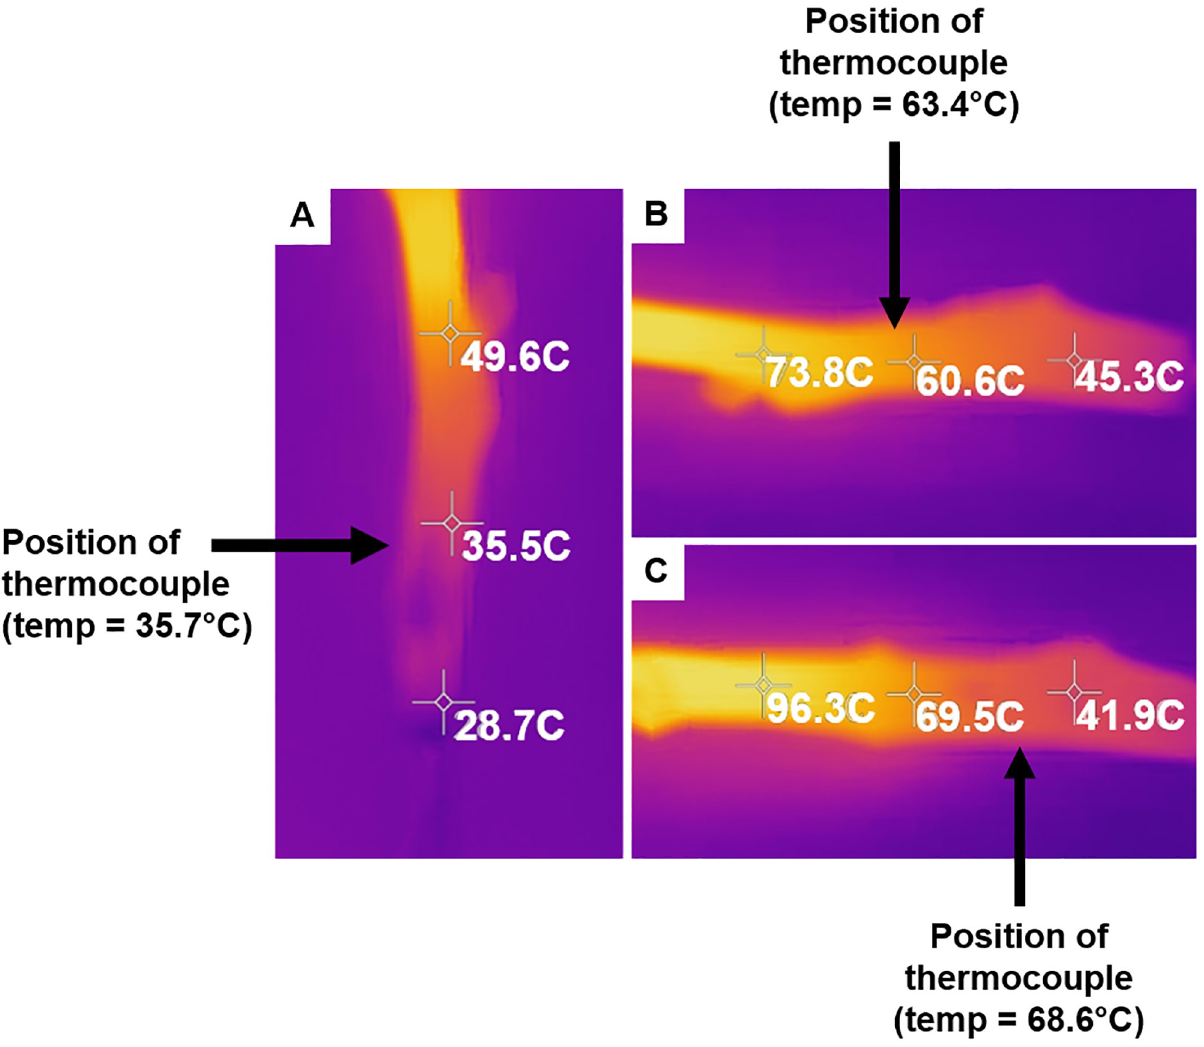
Fig 3. Comparison of temperature measured with a thermal camera and a thermocouple. Three-point measurements were taken with the thermal camera of pecan scion replicates following carbon nanotube (CNT) treatment. A hole was drilled laterally inside the scion pith, and a thermocouple was inserted for single-point temperature measurements. Arrows indicate the position of the thermocouple upon measurement. (A) The thermocouple measured temperature = 35.7˚C. (B) The thermocouple measured temperature = 63.4˚C. (C) The thermocouple measured temperature =